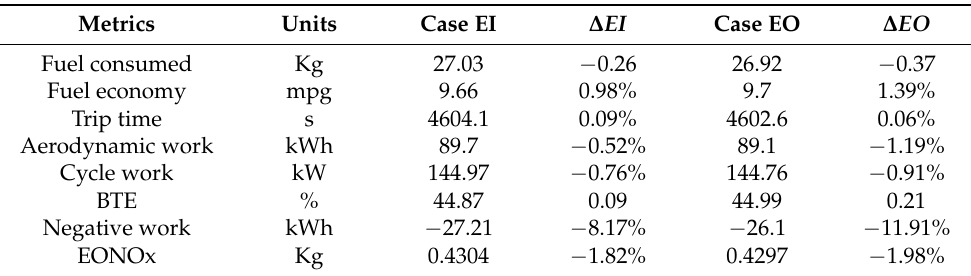
Table 4. Comparison of key metrics for the coast management problem only with engine idle and engine-off condition. The ∆ % is the comparison with the baseline simulation.